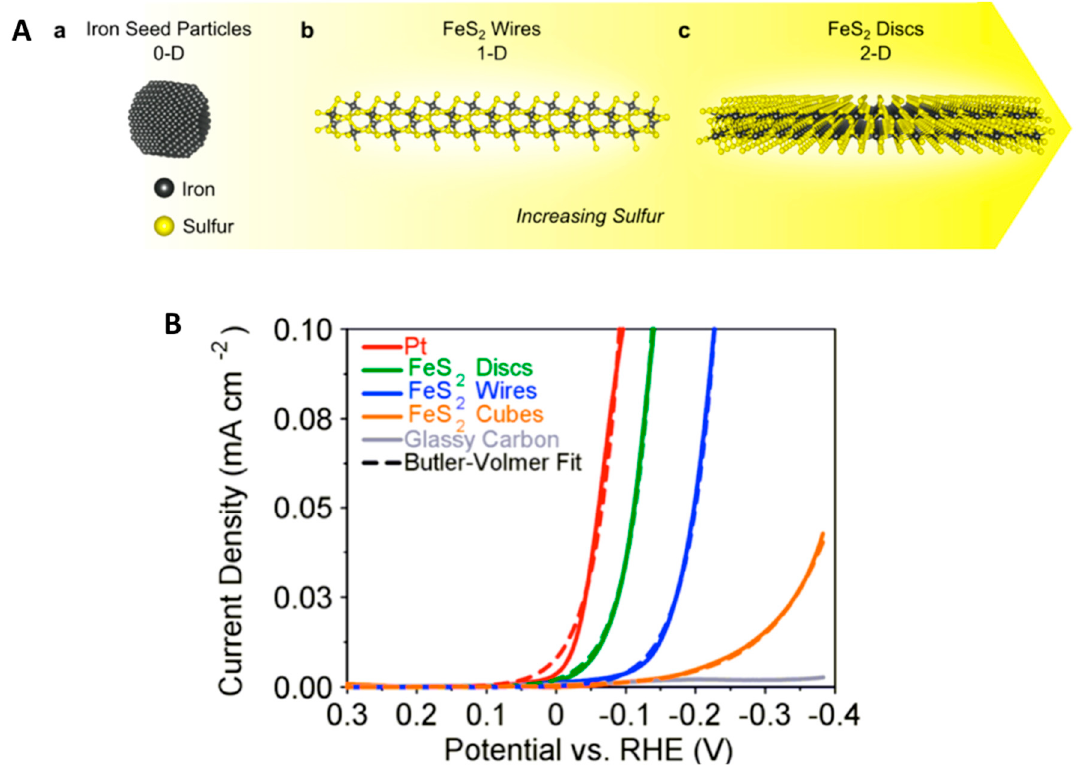
Figure 2. ( A ) Schematic representations of 1D and 2D FeS 2 structure formation. a: Fe nanoparticles (formed in the absence of sulfur), b: FeS 2 wires (formed in a 1:6 Fe/S ratio reaction) and c: FeS 2 discs (formed in a 1:24 Fe/S ratio). ( B ) Experimental linear sweep voltammograms at 1 mV/s for different FeS 2 morphologies (solid lines) and the corresponding best-fit single-electron Butler-Volmer equations (dashed lines). Reprinted with permission from reference [40].